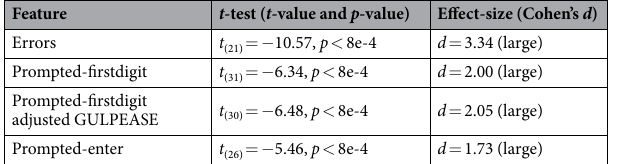
Table 2. Table reports the t-value and p-value of the 4 attributes which revealed a statistically significant difference between the two groups (truthtellers vs liars), considering a significance level of p < 0.0008. Effect- size Cohen’s d is also reported.